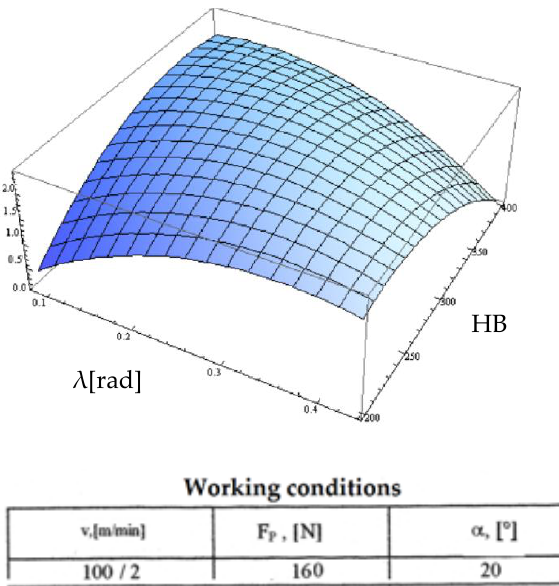
Figure 24. Influence of the inclination angle and hardness on roughness R a.